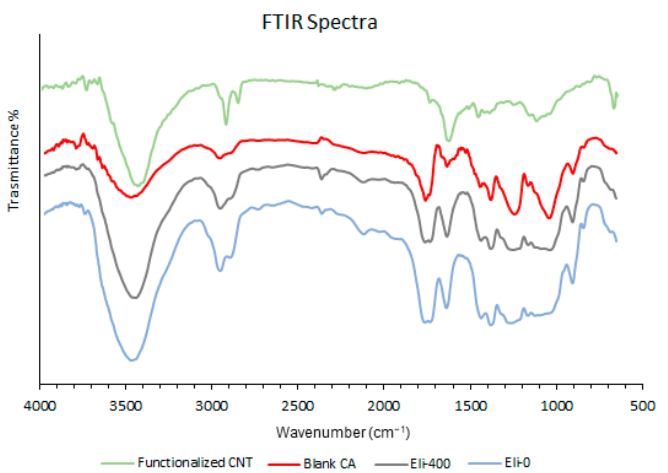
Figure 8. FTIR spectra of functionalized carbon nanotubes, powder cellulose acetate, Eli-0 membrane, and Eli-400 membrane.